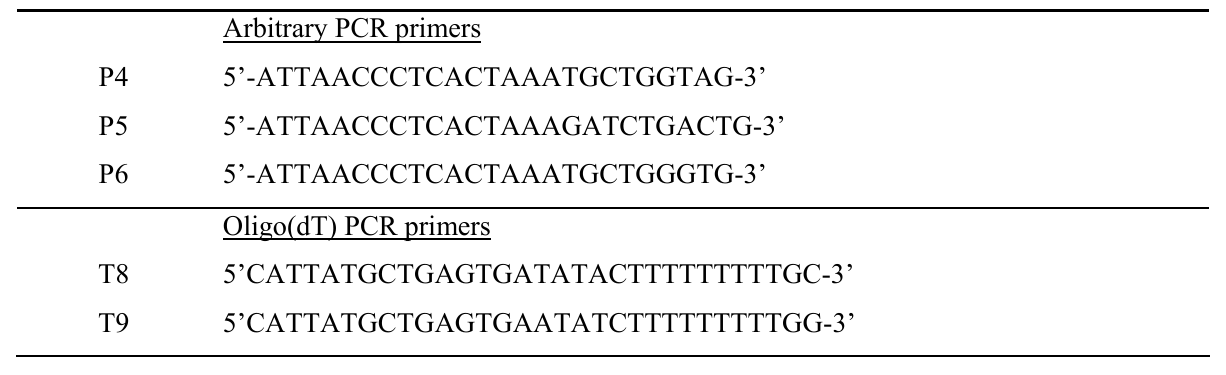
Table 1. Sequences of primers included in the Delta TM RNA fingerprinting